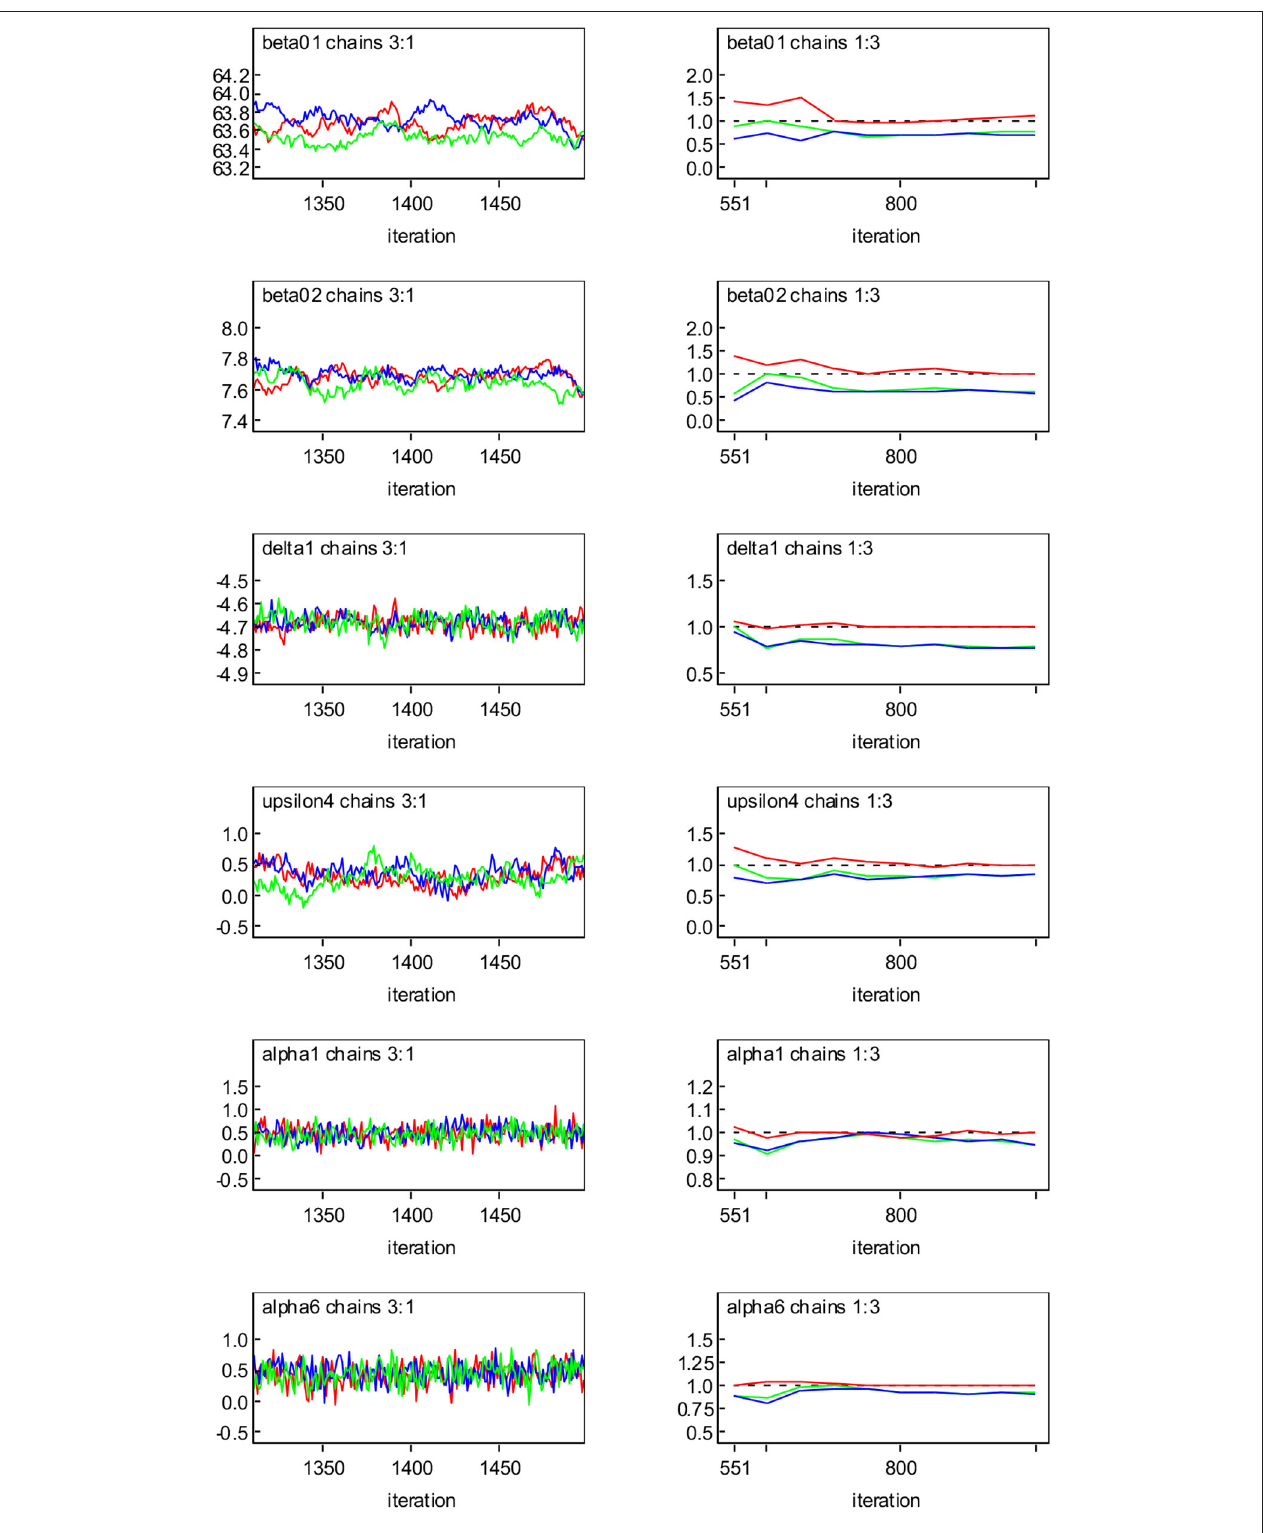
FIGURE 2 | Convergence diagnostics with three Markov chains for representative parameters based on Model SN: trace plots (left panel); Gelman-Rubin (GR) diagnostic plots (right panel), where the middle and bottom curves below the dashed horizontal line (indicated by the value one) represent the pooled posterior variance ( ˆ V ) and average within-sample variance ( ˆ W ), respectively, and the top curve above the dashed horizontal line represents their ratio ( ˆ R ).